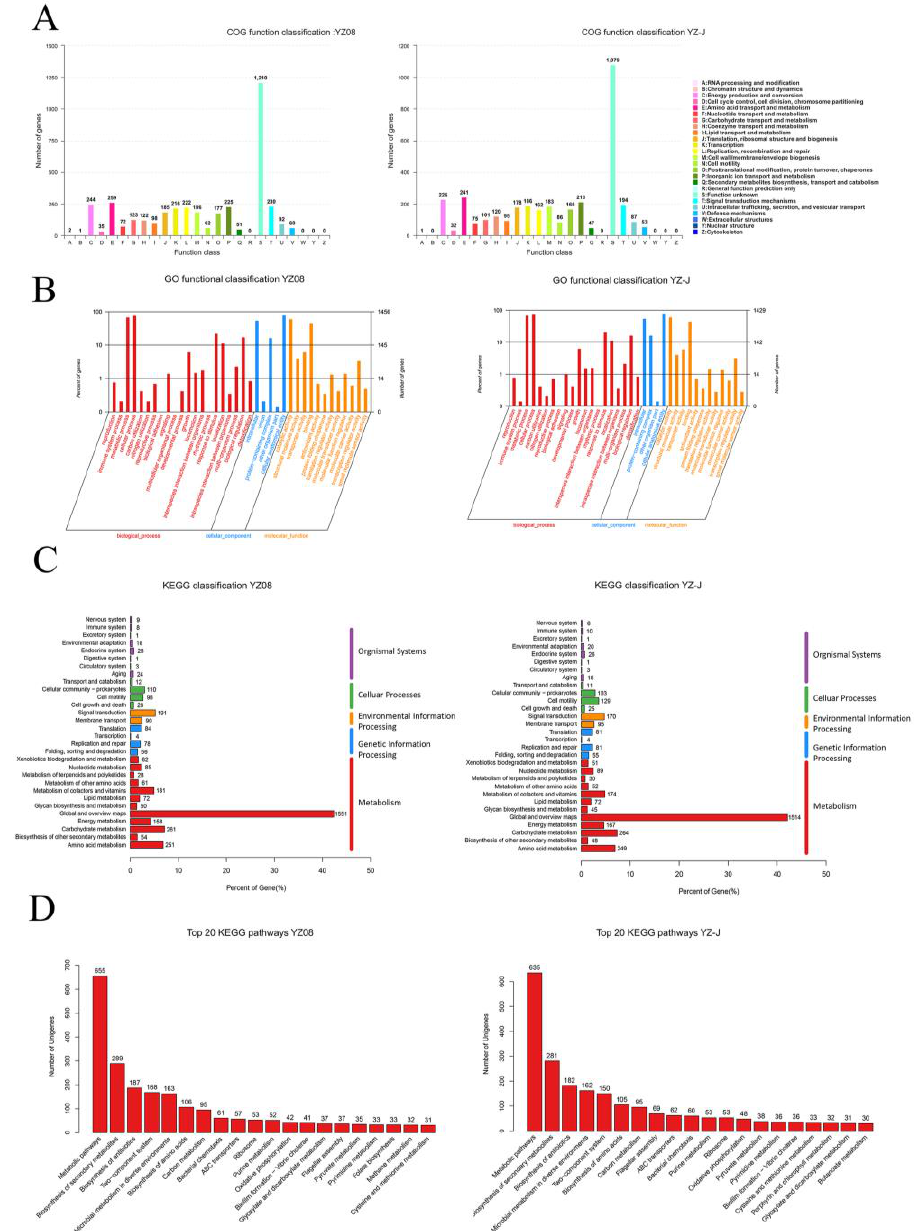
Figure 2. Whole genome sequence analysis of S. putrefaciens YZ08 and YZ-J. ( A ), Cluster of orthologous groups (COG). ( B ), Gene ontology (GO). ( C ), Kyoto Encyclopedia of Genes and Genomes (KEGG) Classification. ( D ), Top 20 KEGG pathways.